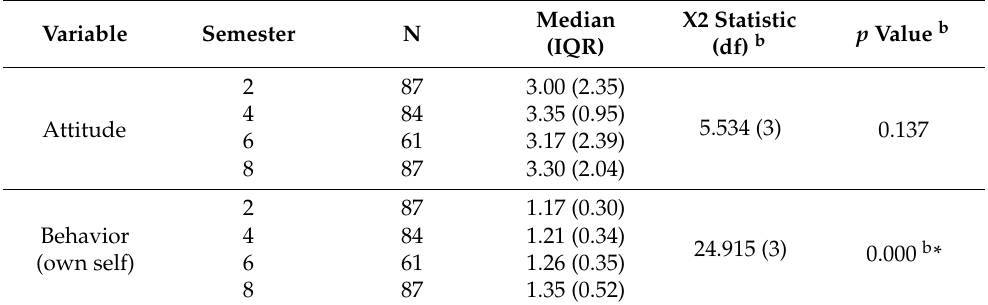
Table 4. Results for students’ attitudes and behavior towards academic dishonesty during online learning among respondents in association with